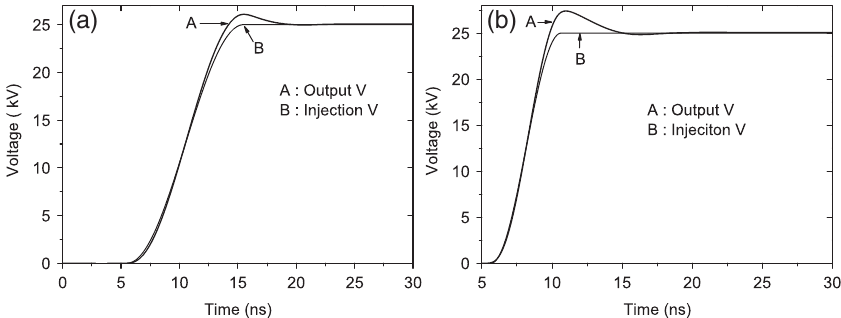
FIG. 7. Response characteristics (a) for rise time of 10 ns and (b) for rise time of 5